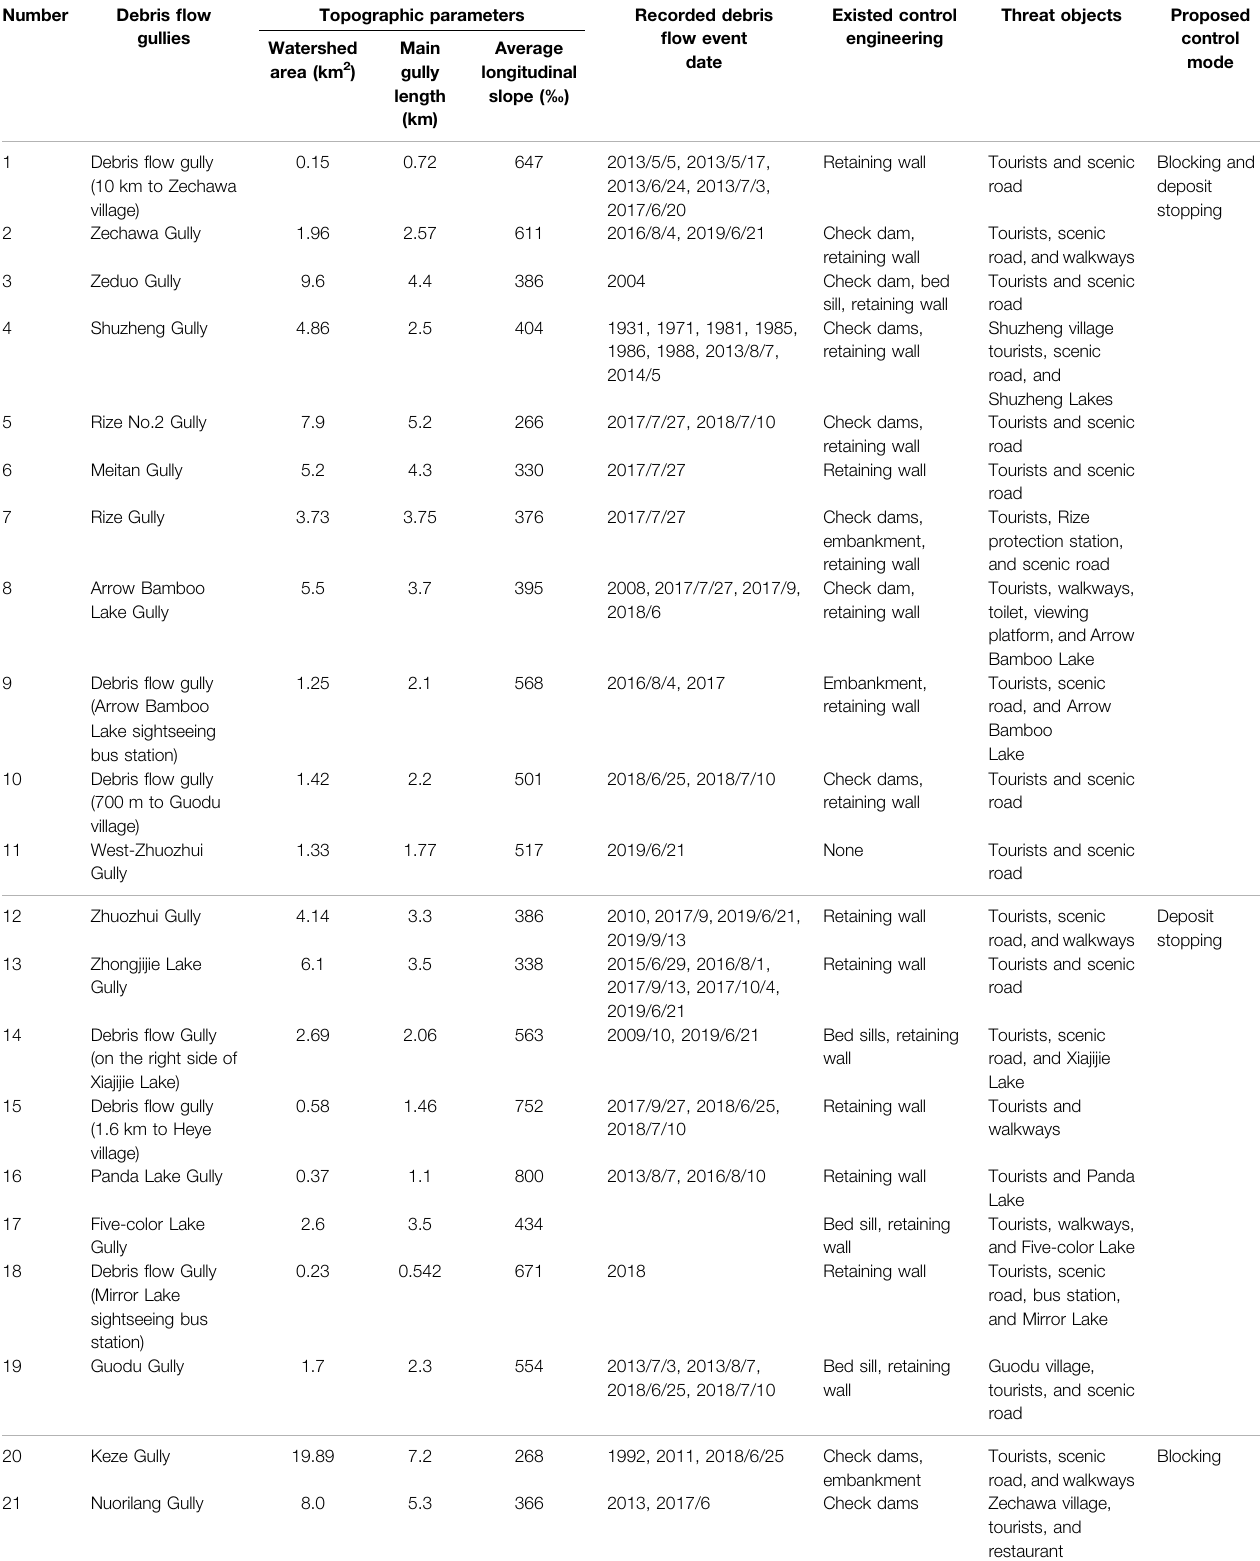
TABLE 4 | Debris fl ow control mode in Jiuzhaigou